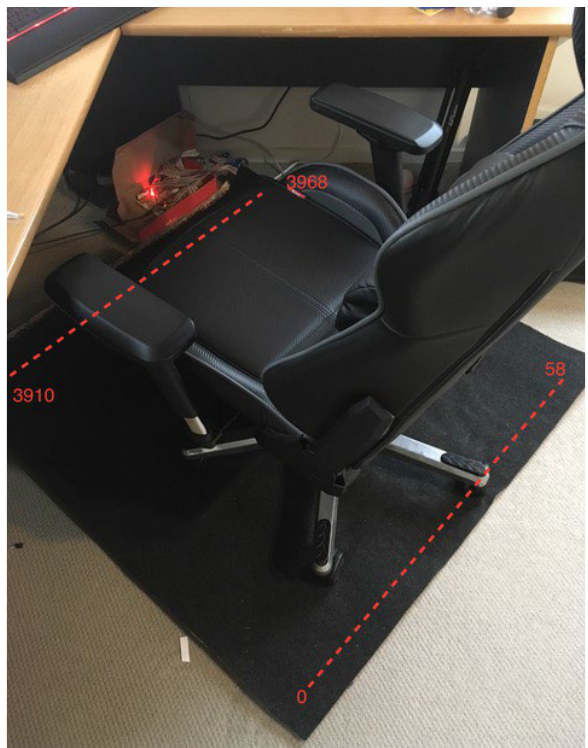
Figure 1. Sensor placed underneath